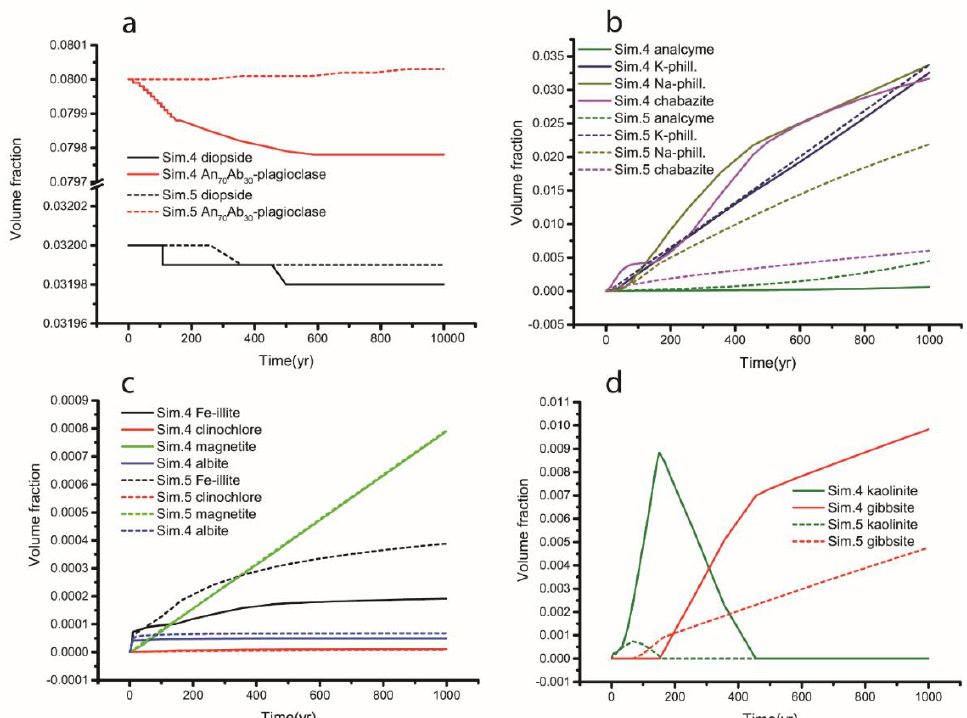
Figure 9. Simulations 4 and 5: mineral evolution (fraction volume) over time at 85 °C and PCO 2 = 0.12 bar (Sim. 4, solid lines) and PCO 2 = 0.012 bar (Sim. 5, dash lines). Initial volume fraction as reported in Table 7. ( a ) Primary diopside and An 70 Ab 30 -plagioclase; ( b ) secondary zeolites; ( c ) secondary Fe-illite, clinochlore, magnetite and albite; ( d ) secondary kaolinite and gibbsite.